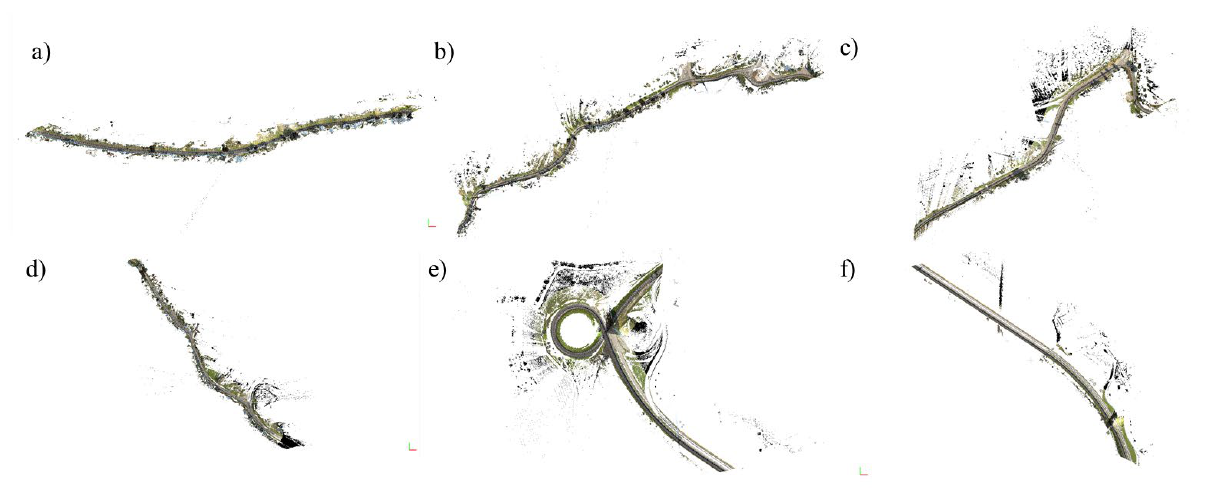
Figure 7. Top view of point clouds acquired in: a)-d) conventional roads, e)-f) highways.